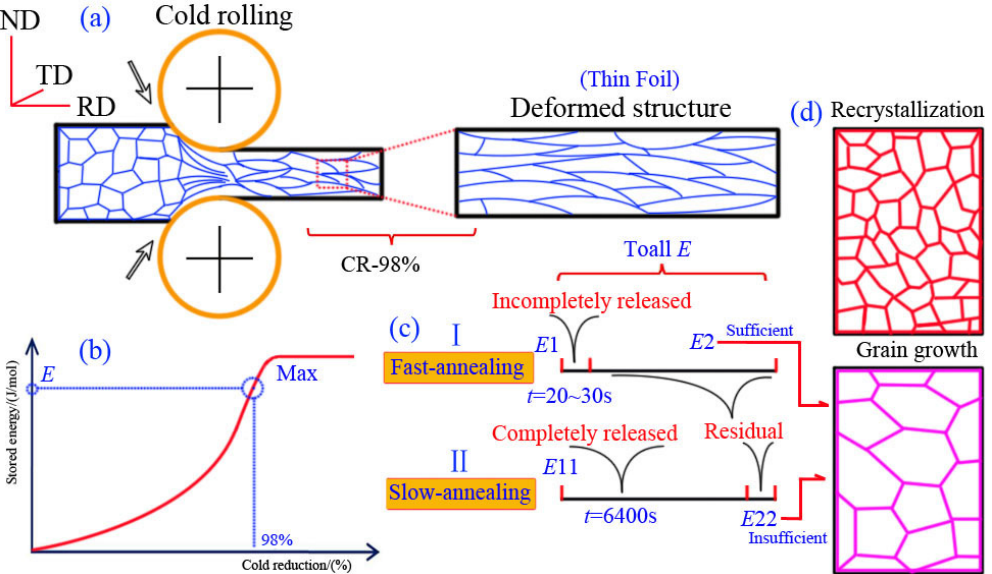
Figure 5. Schematic of deformation stored energy release of high purity aluminum foils during annealing ( a ) cold rolling; ( b ) stored energy versus cold reduction; ( c ) two typical annealing processes; ( d ) microstructure evolution.